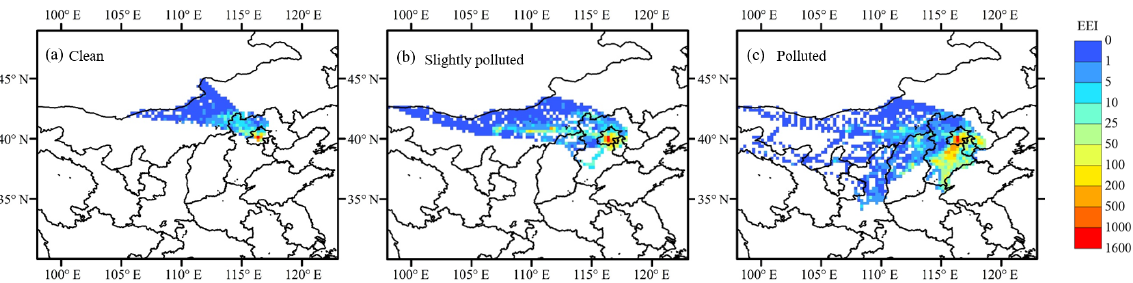
Figure 5. Spatial distribution (0.25 ◦ × 0.25 ◦ ) of the effective emission intensity (EEI, units of tons per grid per year) for BC transported to the observation site (40 ◦ 00’17 (cid:48)(cid:48) N, 116 ◦ 19’34 (cid:48)(cid:48) E) during clean, slightly polluted and polluted periods. The clean (PM 2 . 5 ≤ 35µgm − 3 ), slightly polluted (35µgm − 3 <PM 2 . 5 ≤ 115µgm − 3 ) and polluted (PM 2 . 5 >115µgm − 3 ) periods were classified according to the Air Quality Index (Zheng et al., 2015). The site location and the boundaries of inside the region (i.e., Beijing) vs. outside the region (i.e., other areas such as Tianjin, Hebei, Inner Mongolia, Shanxi and Shandong) are shown in Fig. S1. Note that these regions are defined based on political